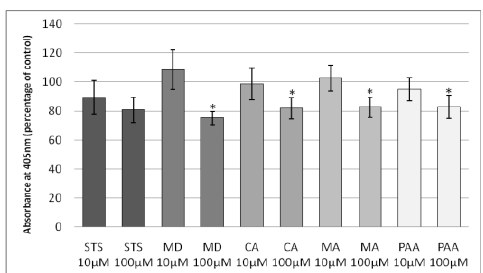
FIGURE1I: ALP activity at 24 hours. Mean ± SEM, n = 12 * significant difference compared to the control p<0.05